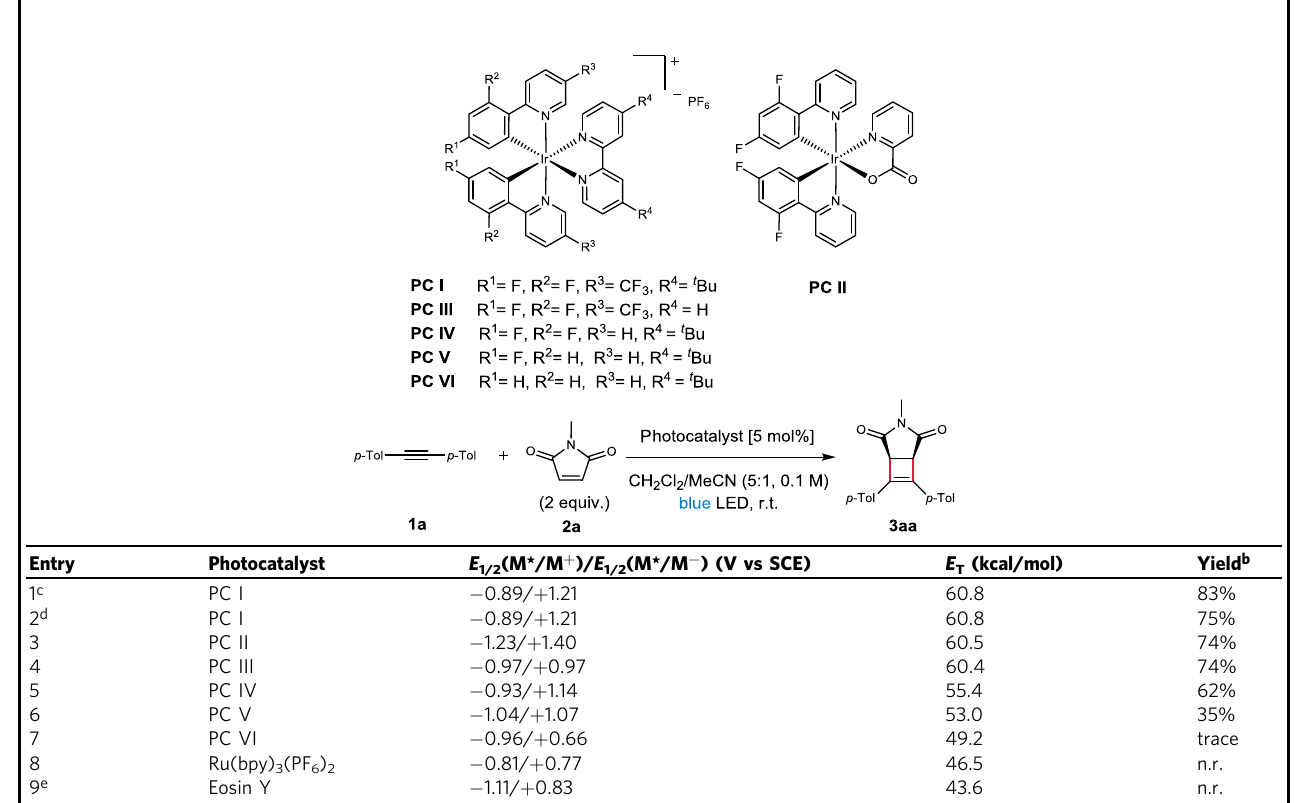
Table 1 Triplet energies and redox potentials of photocatalysts a